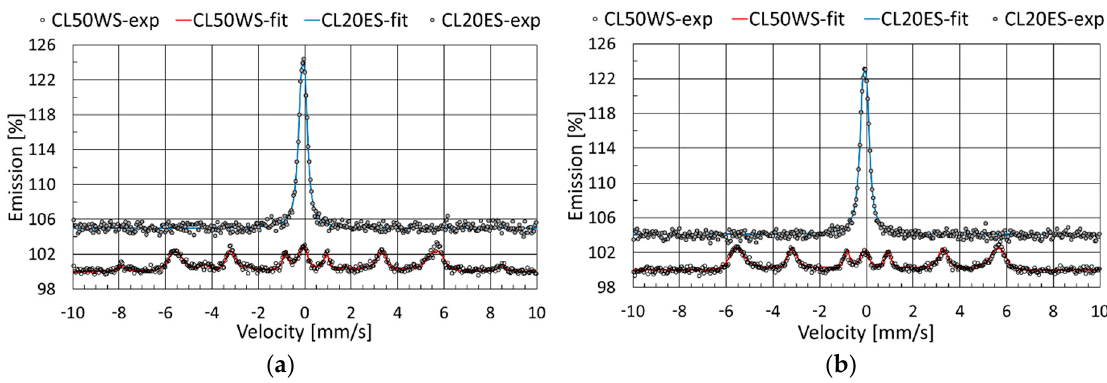
Figure 10. CXMS of ( a ) Sample 2 (CL20ES) and Sample 5 (CL50WS); ( b ) Sample 3 (CL20ES) and Sample 6 (CL50WS). Table 3. Parameters of CEMS.